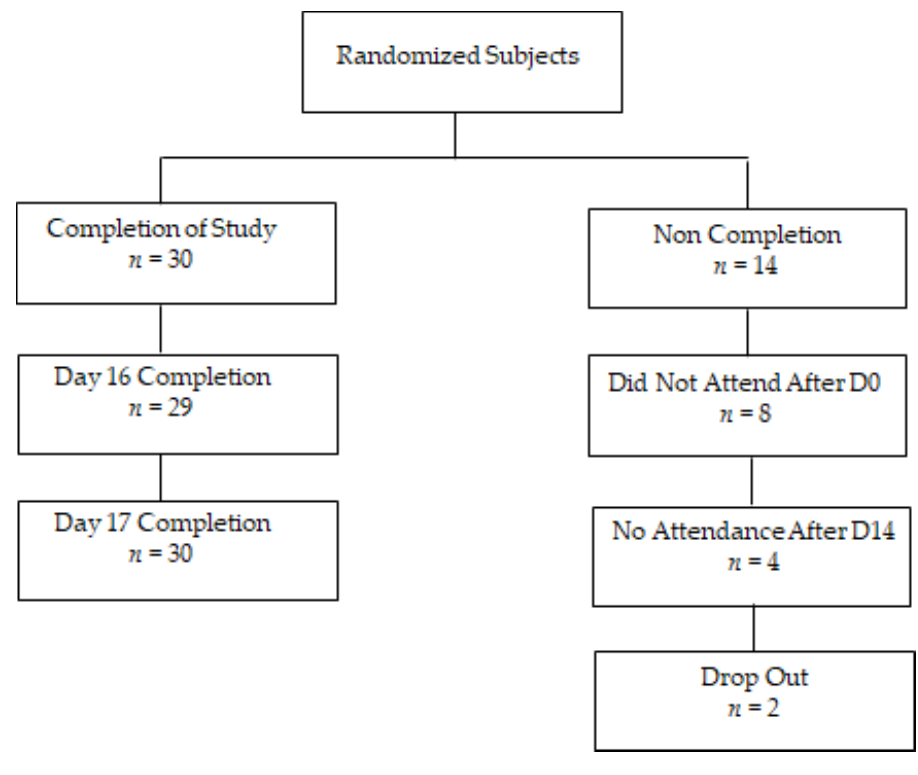
Figure 2. Recruitment flow chart.